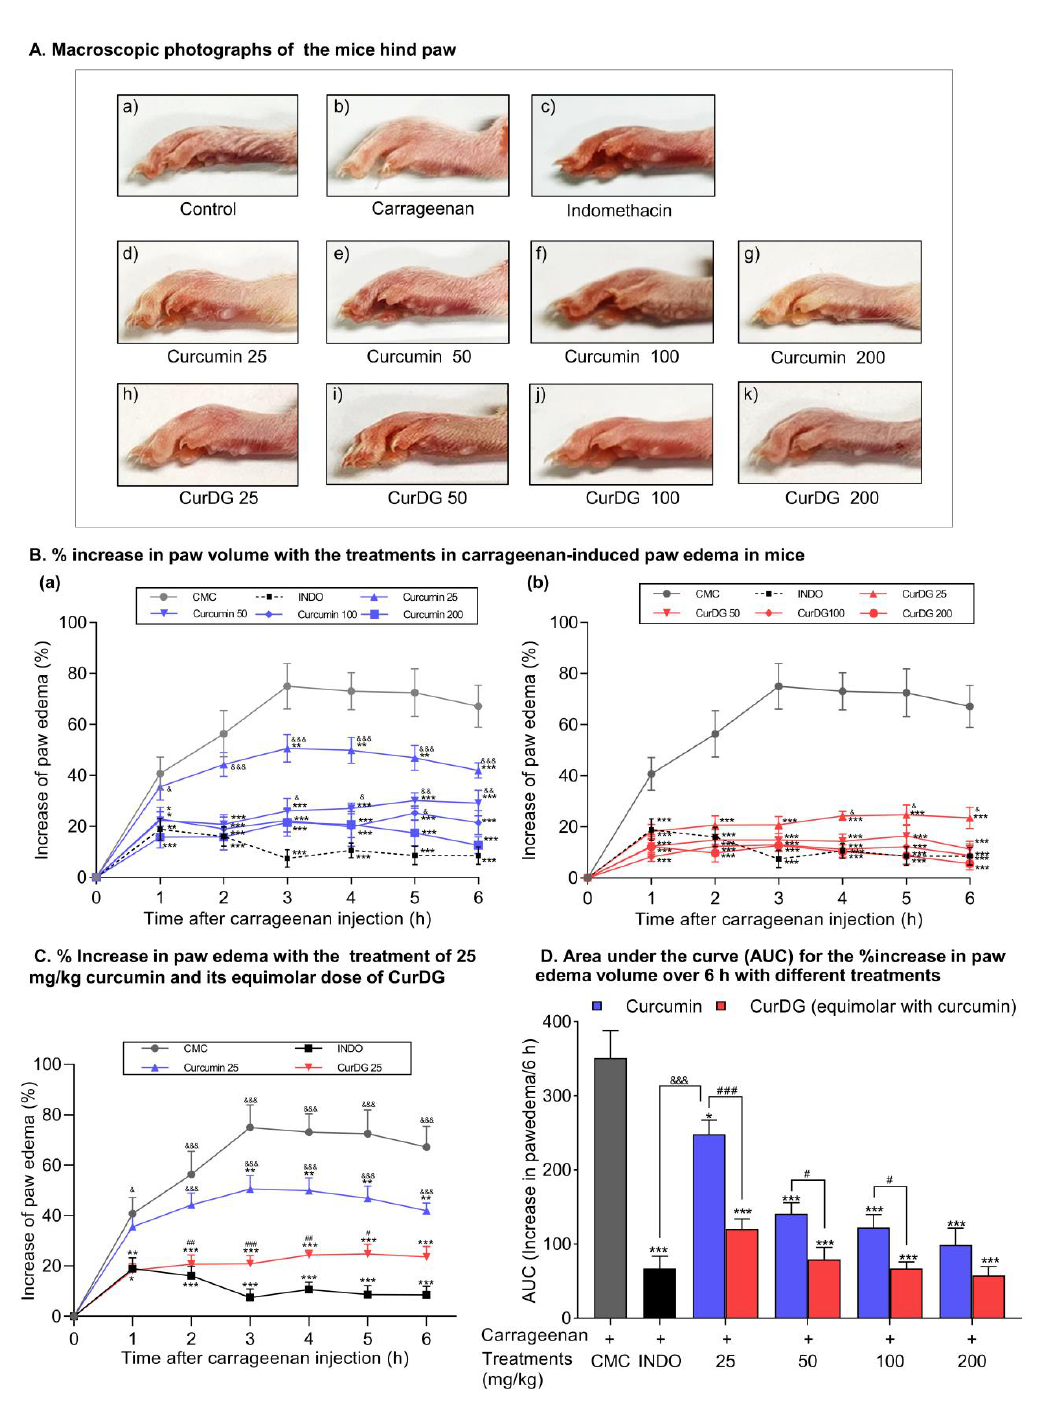
Figure 5. Anti-inflammatory e ff ects of curcumin and CurDG on carrageenan-induced hind paw edema. ( A ) Morphological features of the left hind paw of each mice 6 h after carrageenan administration. ( B ) The percentage increase of paw edema after carrageenan injection following oral administration of 0.5% CMC, indomethacin (10 mg / kg), and curcumin ( a ) and CurDG ( b ) at doses of 25, 50, 100, and 200 mg / kg). ( C ) E ff ect of CurDG 25 on the % increase of paw edema compared to its respective controls. ( D ) The area under the paw edema e ff ect–time curve (AUC 0–6 h). The data are the mean ± SEM for 8 mice. The results were analyzed using an ANOVA and Fisher’s LSD post hoc test. Note: * p < 0.05, ** p < 0.01, and *** p < 0.001 compared to the vehicle-treated control; # p < 0.05, ## p < 0.01 and ### p < 0.001, significant di ff erences between curcumin- and CurDG-treated groups; & p < 0.05, && p < 0.01, and &&& p < 0.001, statistical di ff erences in the treatment groups compared with indomethacin-treated group